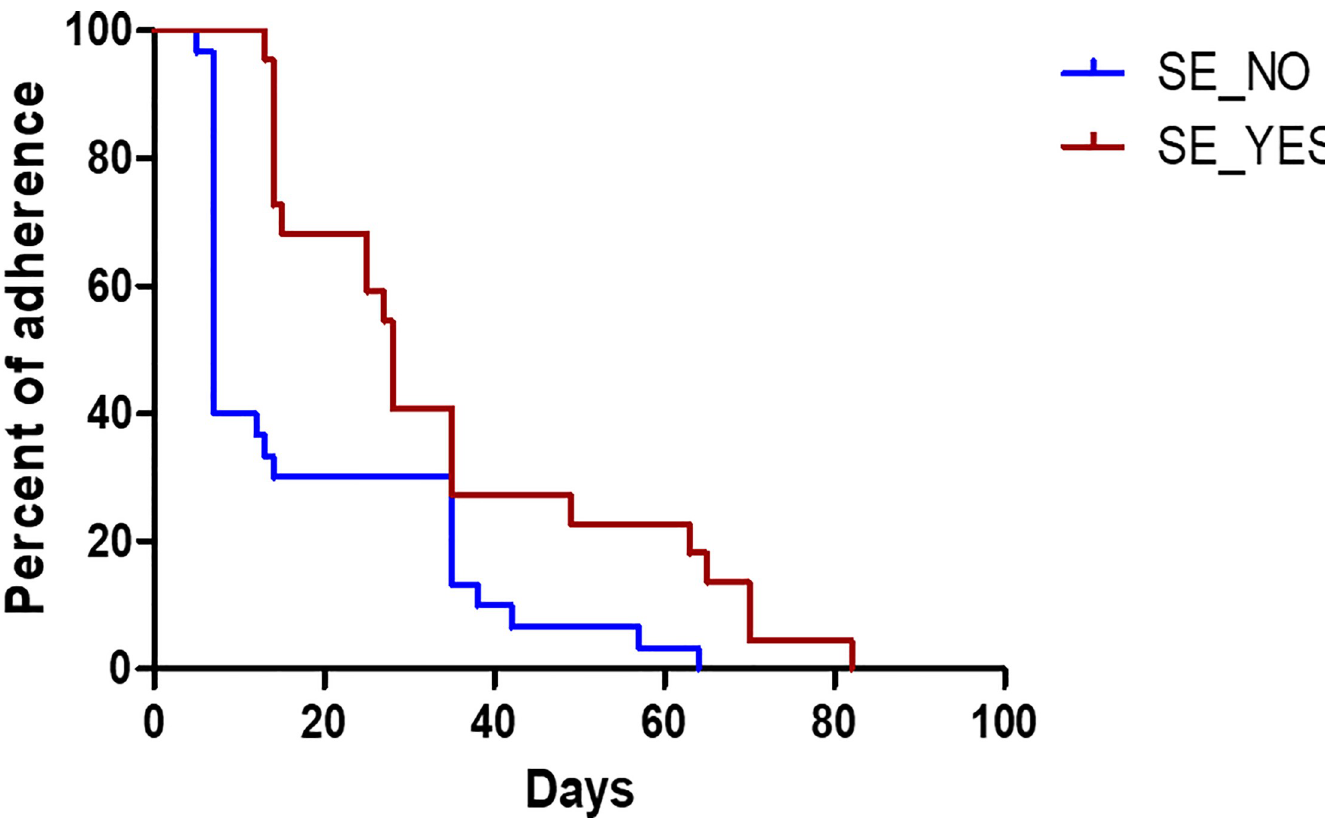
Fig 2. Drop out of LTBI treatment among 52 healthcare workers who did not complete treatment. Among the 52 HCWs who did not complete treatment, most dropped out in the early phase of treatment. In the first 2 weeks, 51.9% HCWs dropped out; 80% of those who did not complete treatment did not present for follow up after 5 weeks. SE, side